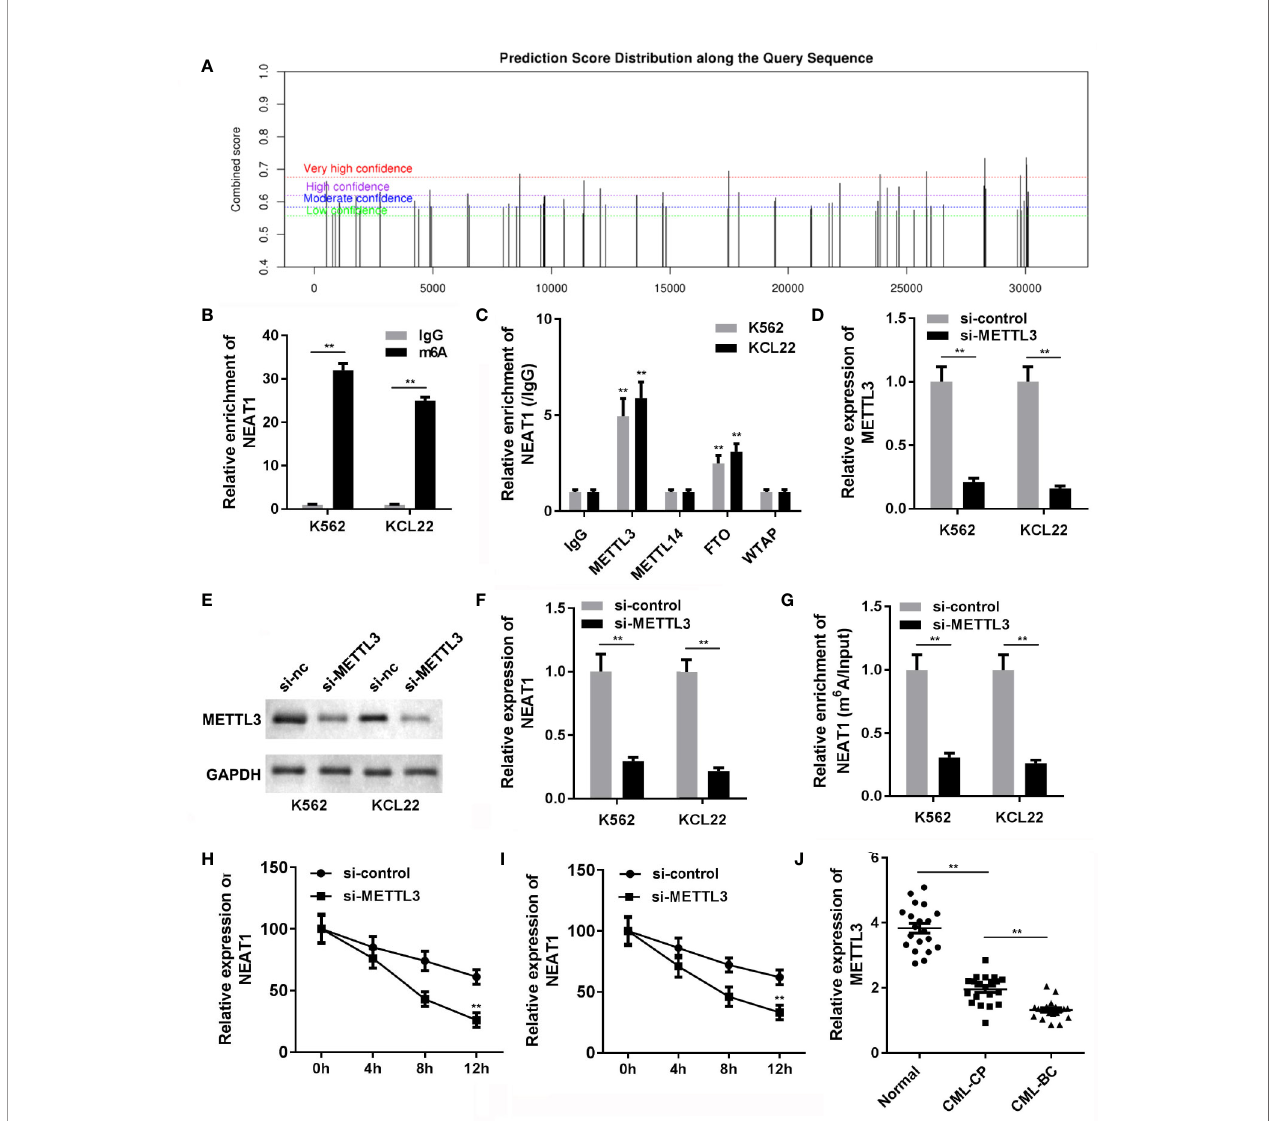
FIGURE 7 | The causal of NEAT1 de fi ciency in CML. (A) The potential m6A modi fi cation sites of NEAT1 were predicted by SRAMP. (B) Anti-m6A antibodies enriched NEAT1 levels in the CML cells. (C) The interaction between NEAT1 and METTL3, METTL14, FTP, or WTAP. (D) The expression of METTL3 in CML cells. (E) The expression of NEAT1 in CML cells. (F) METTL3 induced m6A modi fi cation of NEAT1. (G, H) The mRNA stability of NEAT1 in CML cells. (I) The expression of METTL3 in CML patients. (J) The expression of METTL3 in CML cells. **P < 0.01 vs. IgG or si-NC. CML, chronic myeloid leukemia; NEAT1, lncRNA nuclear enriched abundant transcript 1; CP, chronic phase; BC, blast crisis; NC, negative control; METTL3, methyltransferase like